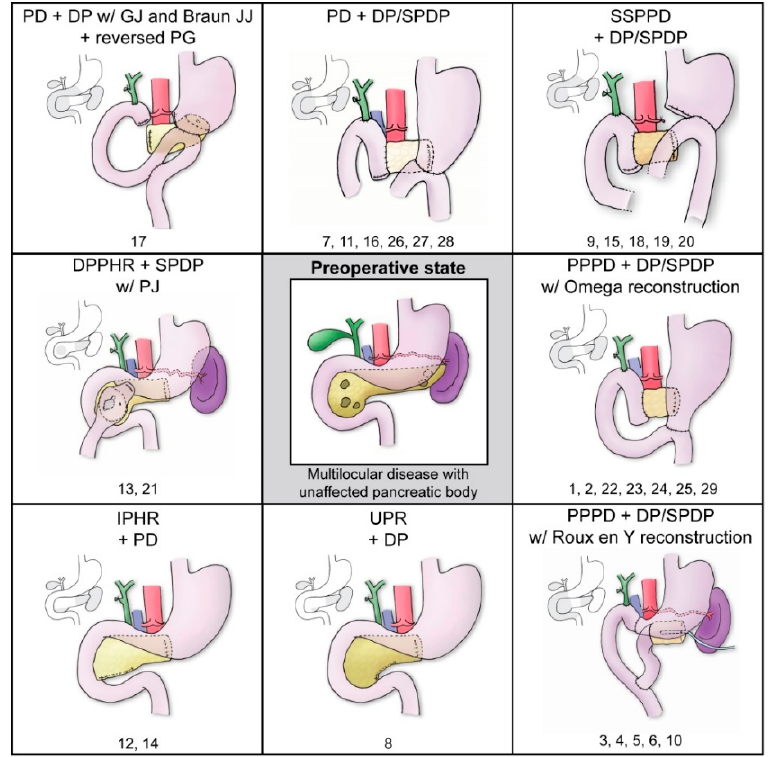
Figure 1. Surgical procedures used for middle-preserving pancreatectomy (MPP), showing final outcomes compared to the preoperative state in the middle. Smaller illustrations in grey indicate the resection targets. Structures displayed in the figures are: (i) pancreas (yellow) with multilocular disease (brown spots), (ii) gastroenteric tract (pink), (iii) gallbladder/ligated cystic bile duct and extrahepatic bile ducts (green), (iv) spleen (purple), (v) aorta with celiac trunk and splenic artery (red), (vi) portal vein (blue), and (vii) temporary gastric tube (light blue, attached to pancreatic stump in PPPD w/Roux en Y reconstruction). The numbers below the procedures are the associated patient IDs. DP: distal pancreatectomy with splenectomy. DPPHR: duodenum preserving pancreatic head resection. GJ: gastrojejunostomy. IPHR: inferior pancreatic head resection. JJ: jejunojejunostomy. PD: pancreaticoduodenectomy. PG: pancreaticogastrostomy. PJ: pancreaticojejunostomy. PPPD: pylorus- preserving pancreaticoduodenectomy. SPDP: spleen preserving distal pancreatectomy. SSPPD: subtotal stomach preserving pancreaticoduodenectomy. UPR: uncinate process